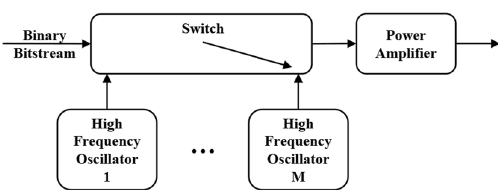
Fig. 2 Structure of an MFSK communication